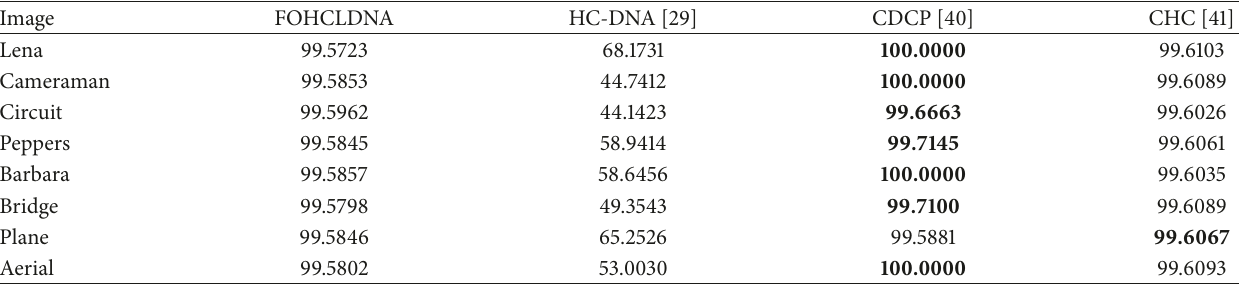
Table 8: The average NPCR (%) of running the schemes 10